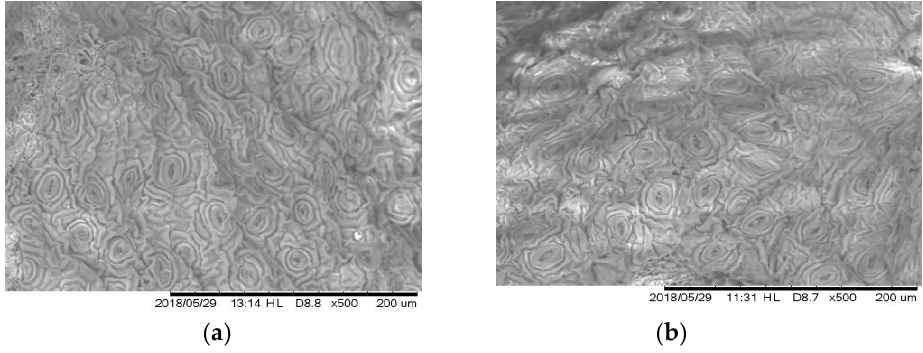
Figure 9. Scanning electron micrographs of ( a ) C10-AGT and ( b ) C12-AGT.